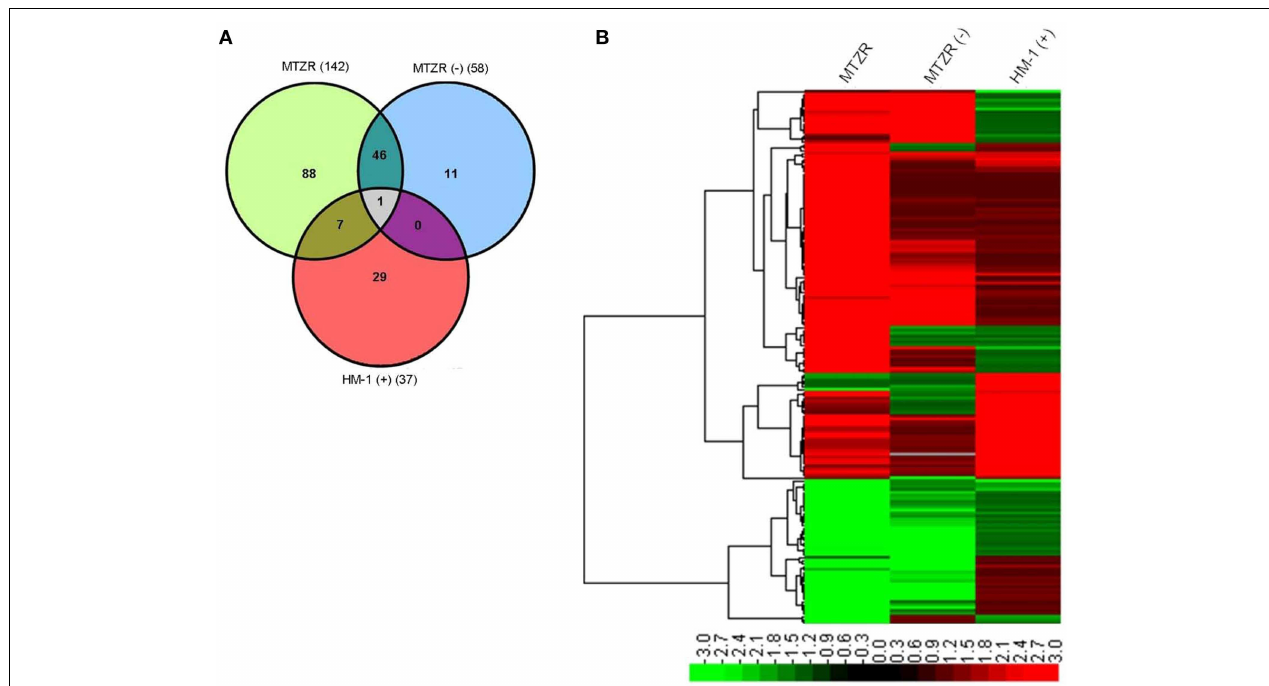
FIGURE 3 | Venn diagram (A) and heat map (B) of modulated genes in MTZR, MTZR ( − ), and HM-1 ( + ). Note that most of genes that were transcriptionally regulated in MTZR were specific to the strain when cultured with MTZ.